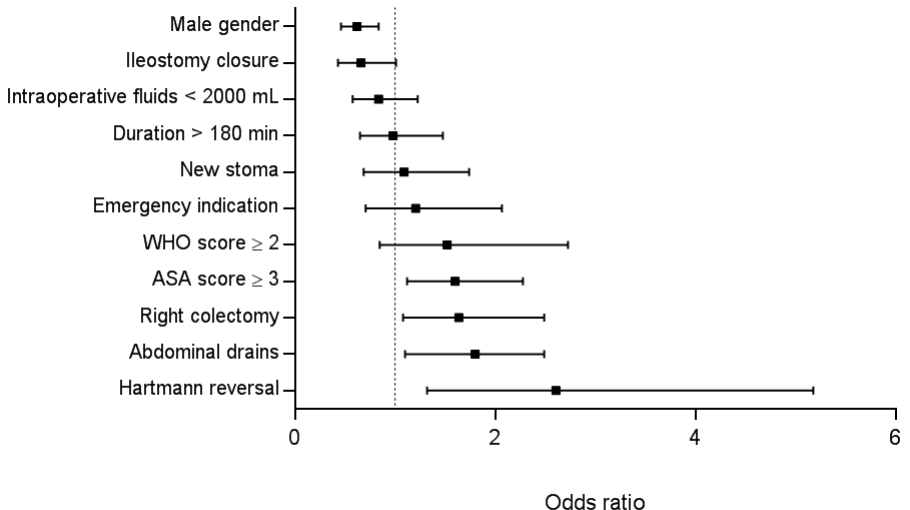
Figure 2. Multivariate analysis. Multivariate analysis of univariate factors with p < 0.05 associated with delayed tolerance of normal diet. An Odds ratio of more than 1 increases the risk of delayed normal diet. ASA: American Society of Anaesthesiology; WHO score: World Health Organisation performance score; Odds ratio: 95% Confidence